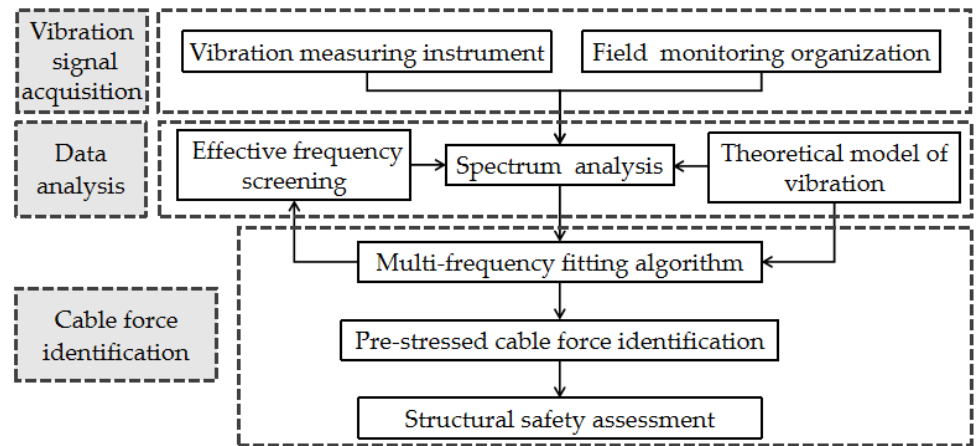
Figure 18. Functional scheme of the cable safety monitoring system.